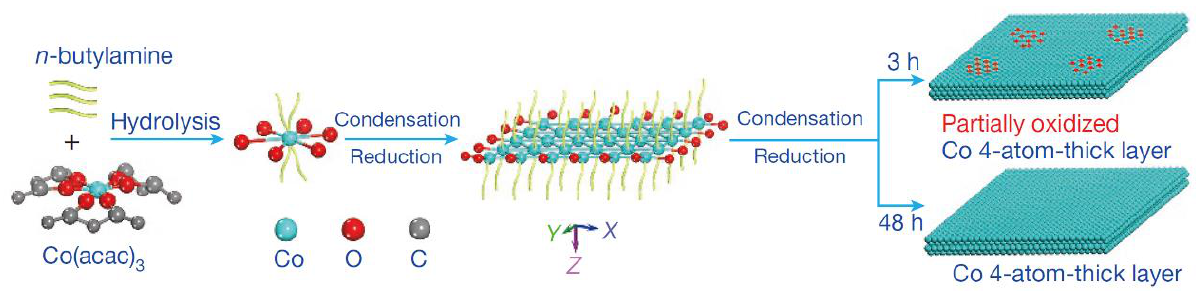
Figure 10. Schematic formation process of the partially oxidized and pure-Co 4-atomic-layer, respectively. Reprinted from Ref. [124], copyright (2016), with permission from Springer Nature.